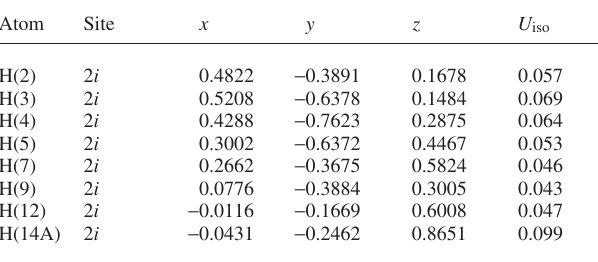
Table 2. Atomic coordinates and displacement parameters (in Å 2 )